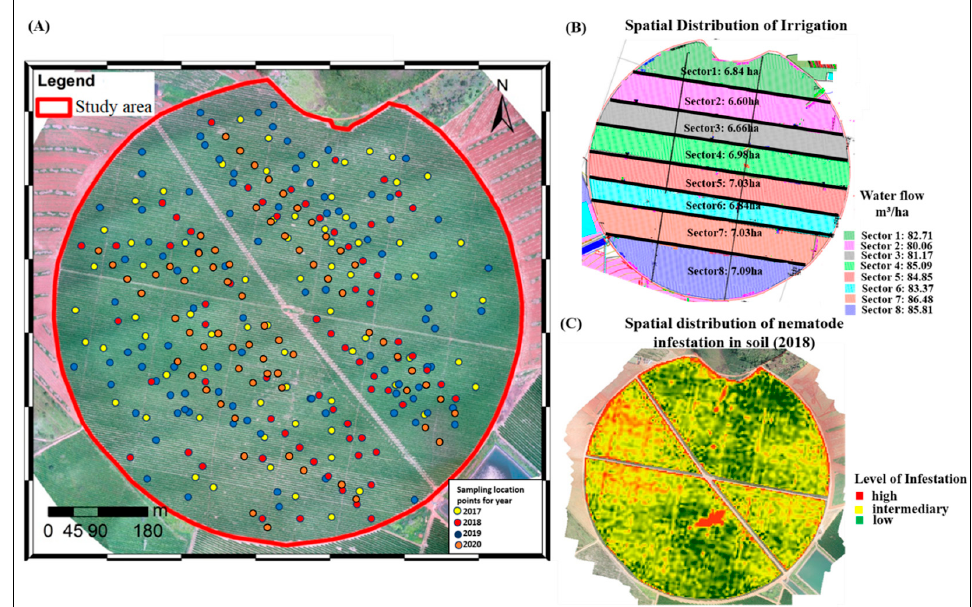
Figure 1. ( A ) Map of the study area and yield sample sites for 2017 to 2020; ( B ) spatial distribution map of different irrigation sectors; ( C ) soil distribution map of soil nematodes.